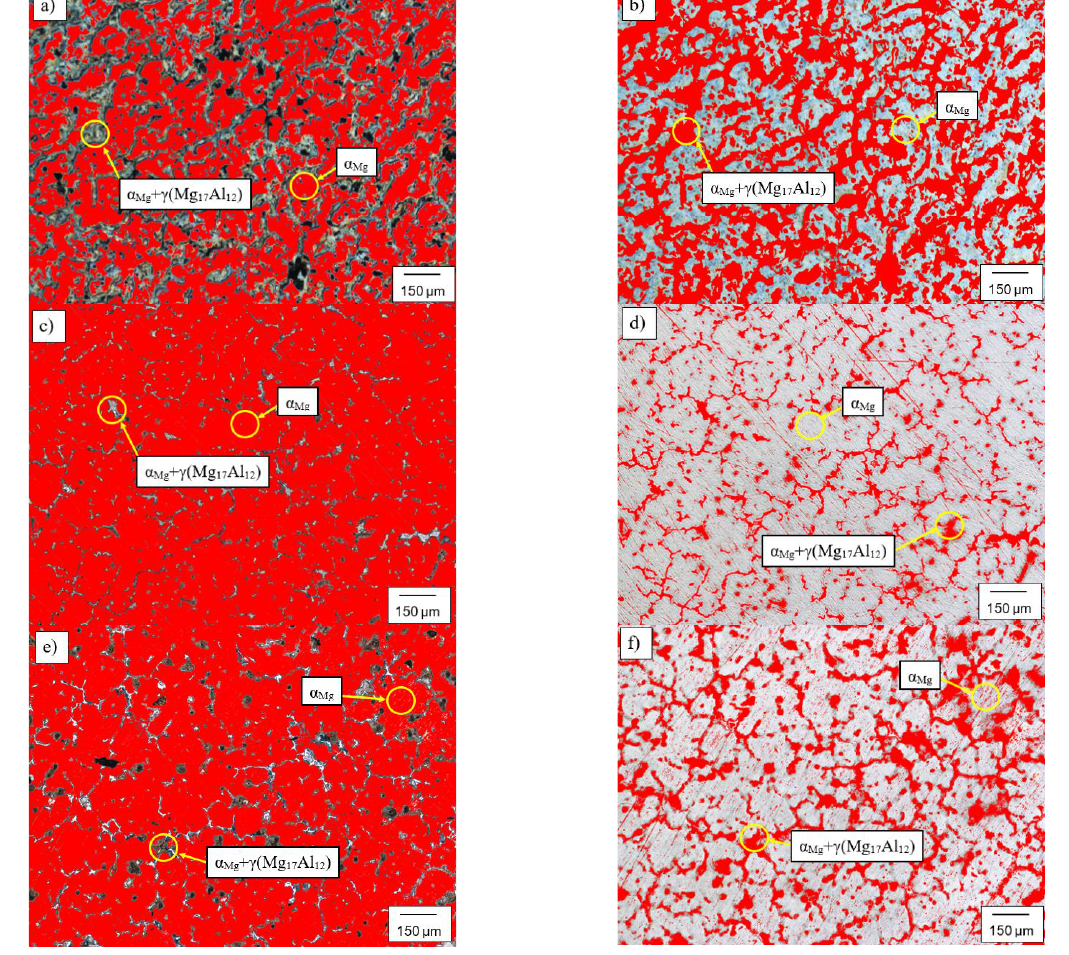
Figure 4. Microstructures subjected to a statistical image analysis of: ( a , b ) — alloy AZ91 subjected to a statistical image analysis:, ( c , d ) — microstructure of AZ91 alloy with 0.3 wt % Zr and ( e , f ) — microstructure of AZ91 alloy with 0.6 wt % Zr.